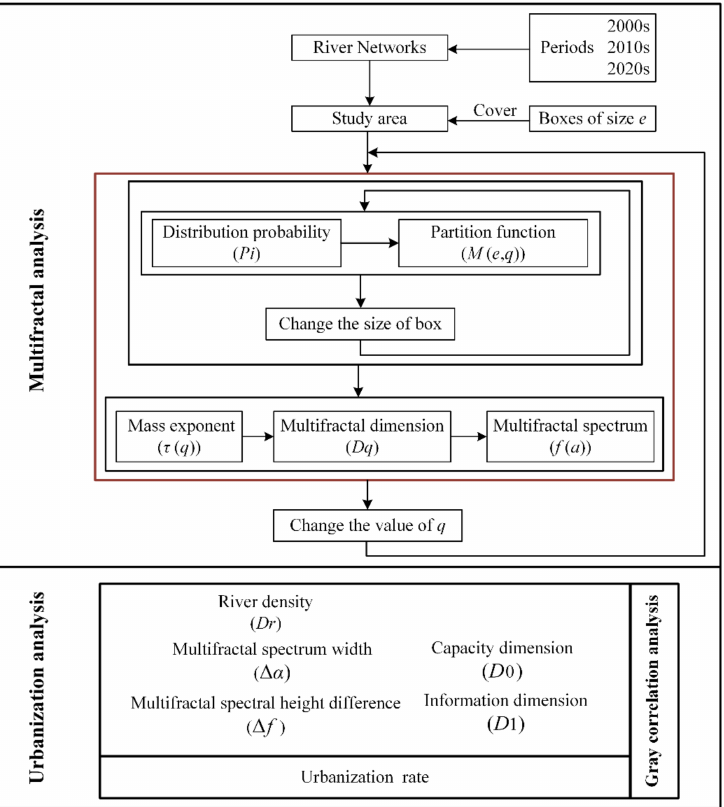
Figure 2. The study